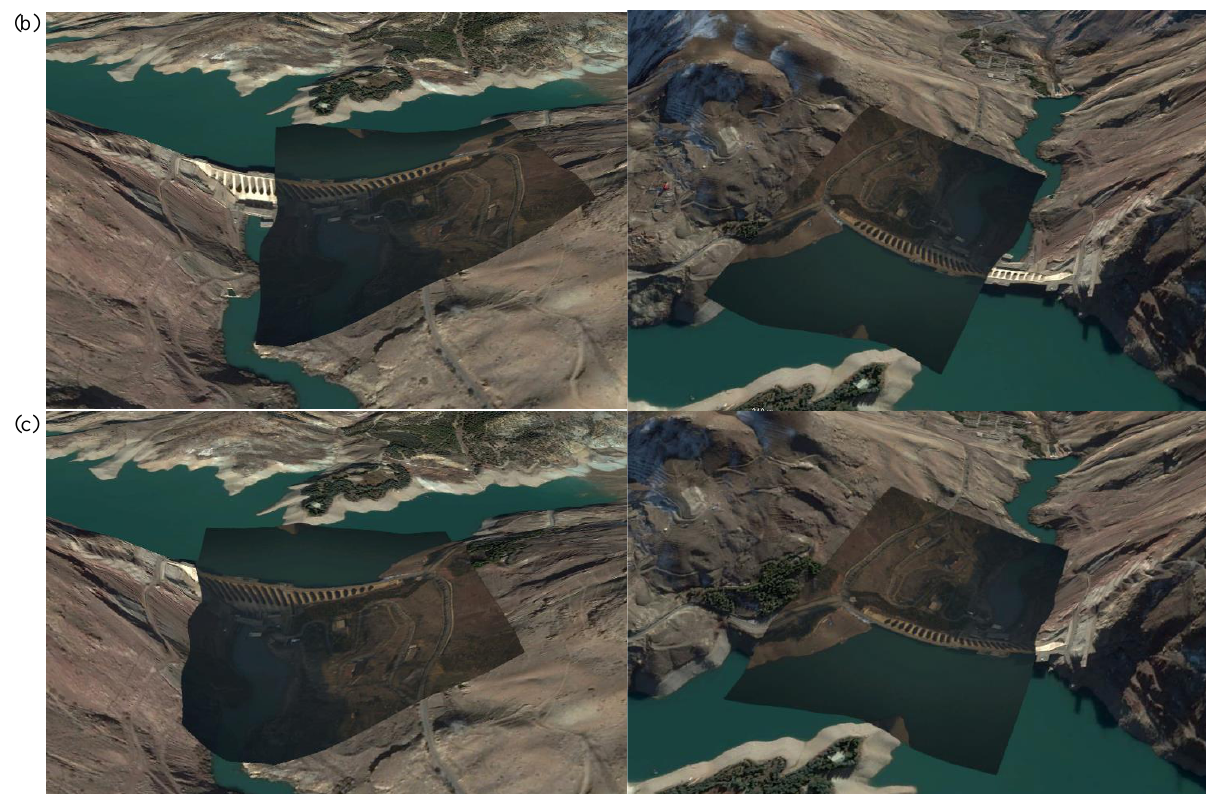
Figure 9. Geo-referenced image frames overlaid on (a) reference image resulted from (b) initial coarse and (c) fine EOP